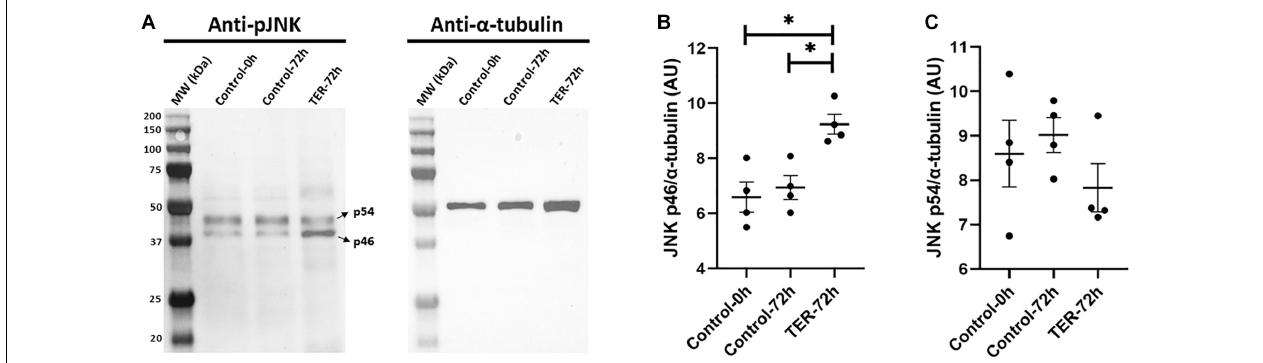
FIGURE 3 | (A) Immunoblotting of pig sperm lysate for pThr183 and pTyr185 of JNK (p46 and p54 splicing variants) and α -tubulin. Subsequent band intensity quantification and normalization of (B) p46 and (C) p54 splicing variants of JNK, normalized using α -tubulin, showed a significant increase in Thr183 and Tyr185 phosphorylation in the p46 variant ( p < 0.05), but not in the p54 variant ( p > 0.05), in TER-treated samples (TER-72h) compared to control samples (control-0h and control-72h). Lanes: MW (kDa), molecular weight; control-0h, semen samples at 0 h of storage; control-72h, vehicle control (dimethyl sulfoxide; DMSO) semen samples at 72 h of storage at 17 ◦ C; TER-72h, semen samples treated with 100 µ M ezatiostat (TER) for 72 h of storage at 17 ◦ C. These results are representative of four independent experiments ( n = 4). * p ≤ 0.05.